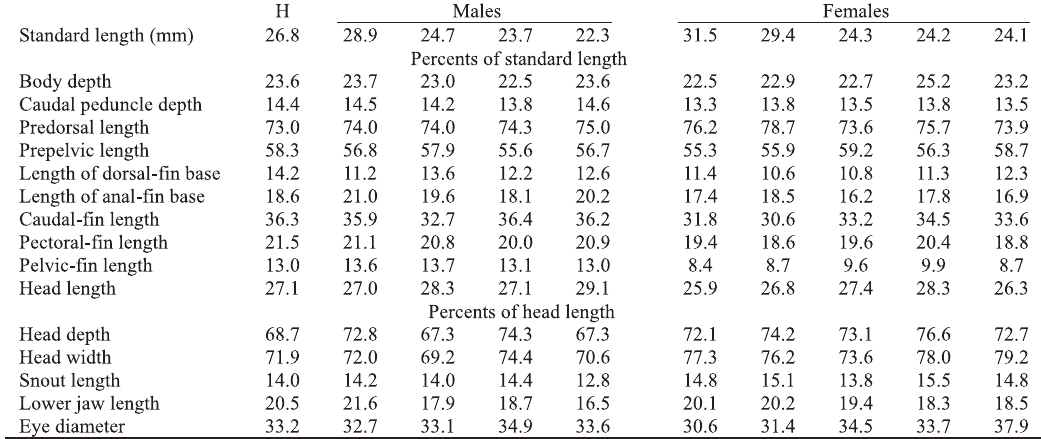
Table 6. Morphometric data of the holotype (H, UFRJ 5968, male) and paratypes (UFRJ 5969) of Rivulus scalaris .